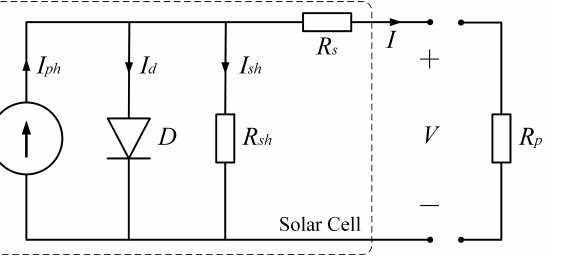
Figure 3. The equivalent circuit of a solar cell consists of a constant current source, a diode D , a shunt resistor R sh , and a series resistor R s . Resistor R p on the right-hand side is the payload resistor. Typically, the series resistance R s is magnitudes smaller than the shunt resistance R sh .